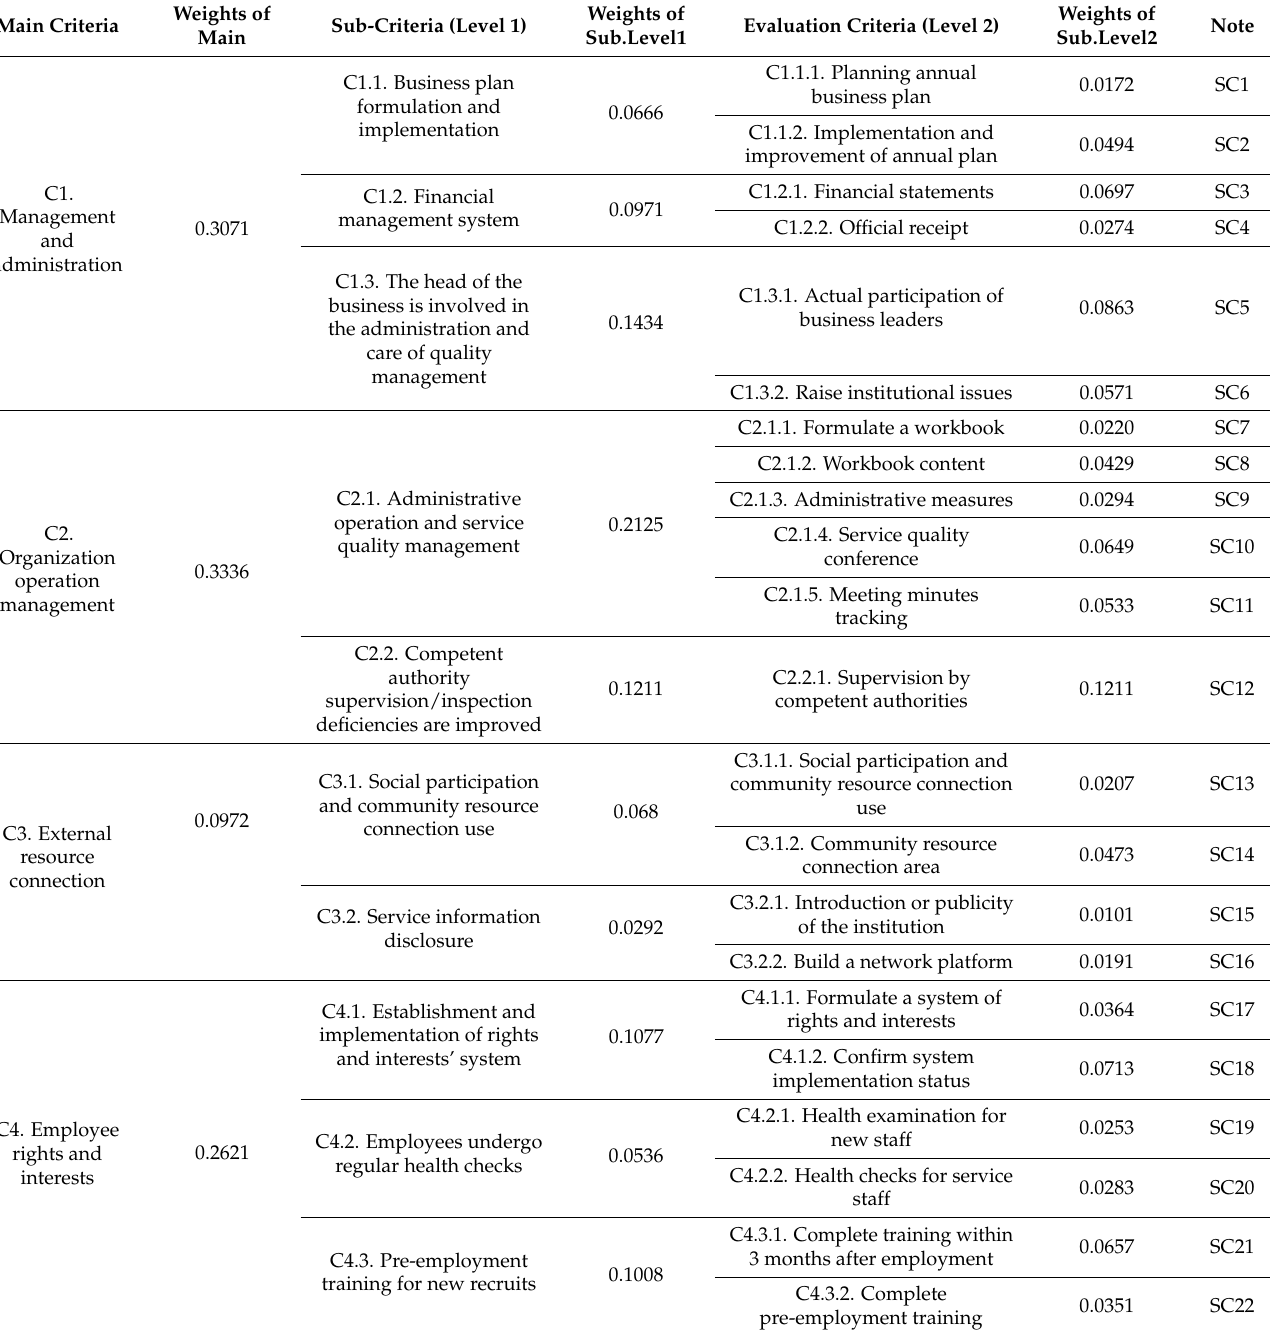
Table 5. Results of fuzzy weights from the FAHP